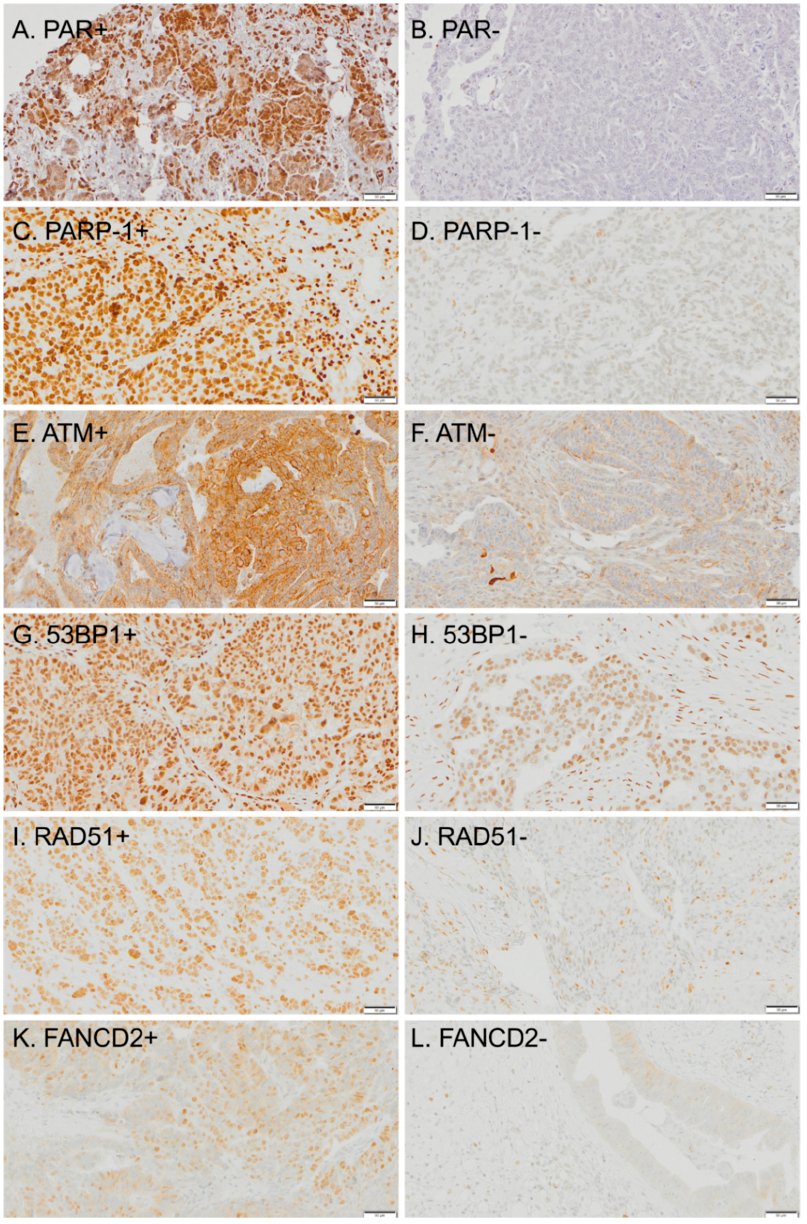
Figure 2. Immunohistochemical (IHC) staining pattern of DDR markers. Scale bar = 50 µm